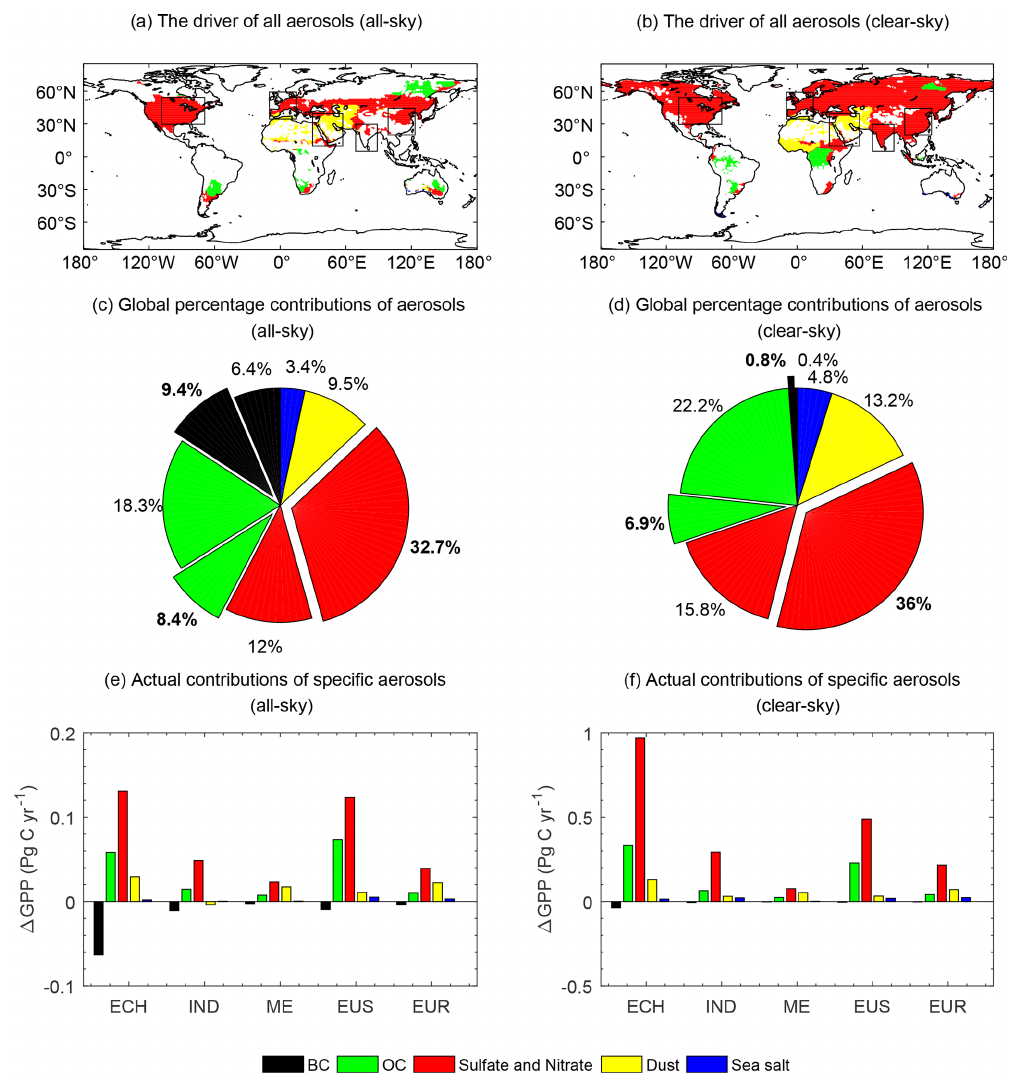
Figure 6. (a, b) Dominant aerosol species contributing to the simulated changes in annual GPP, (c, d) percentage contributions of aerosol species to global GPP, and (e, f) actual DFE of aerosol species in specific regions under (a, c, e) all skies and (b, d, f) clear skies. The contributions in (c) and (d) are calculated as the ratios of absolute DFE, as BC aerosols induce negative DFE. The normal (bold) fonts in (c) and (d) represent aerosol species from natural (anthropogenic) sources. Regions with relatively high percentage changes in GPP ( > 1% for all-sky and > 5% for clear sky) by aerosols are shown in (a) and (b) . The regions include eastern China (ECH), India (INA), the Middle East (ME), the eastern US (EUS), and Europe (EUR), which are marked as black boxes in (a) and (b) . Black, green, red, yellow, and blue represent the effects of BC, OC, sulfate and nitrate, dust, and sea salt aerosols,